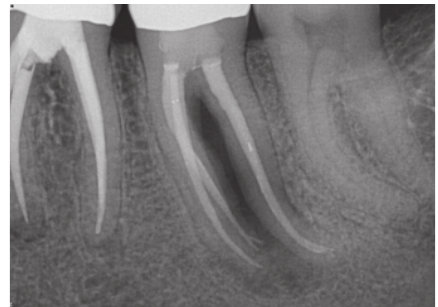
Figure16:Implantwasplacedat4monthsusingaflaplessapproach.